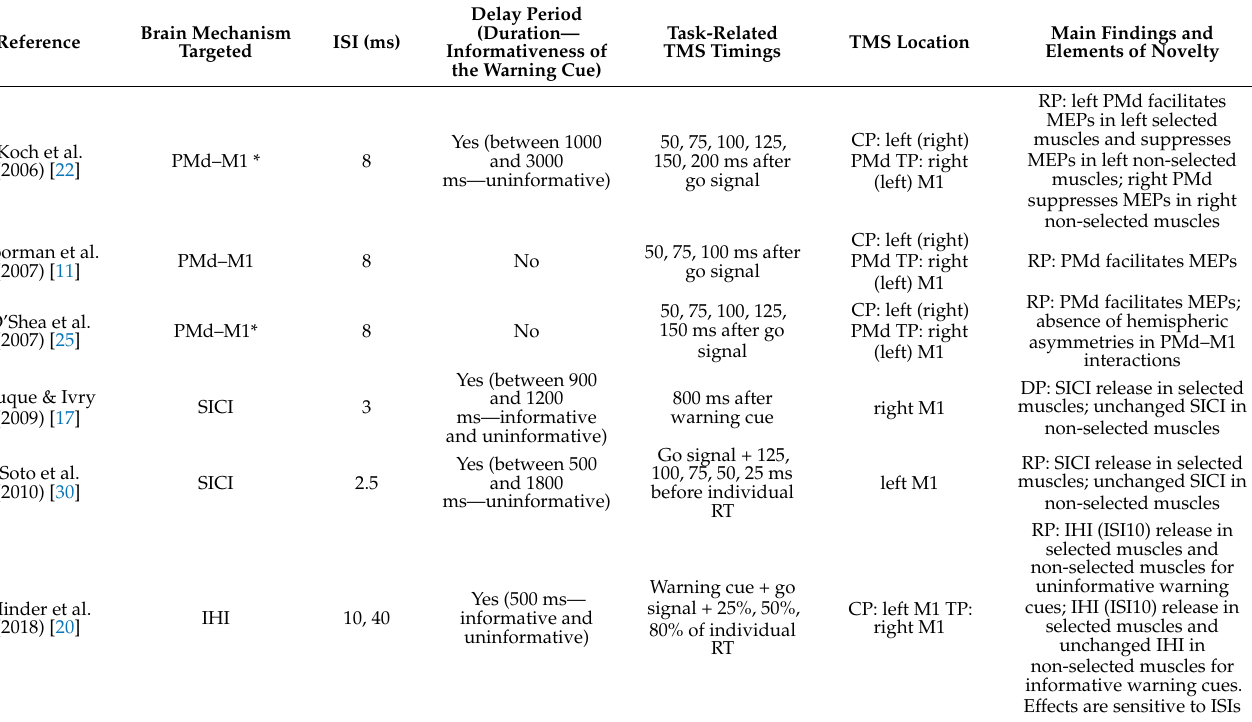
Table 2. Characteristics of key studies using ppTMS and dual-site TMS in the context of choice RT